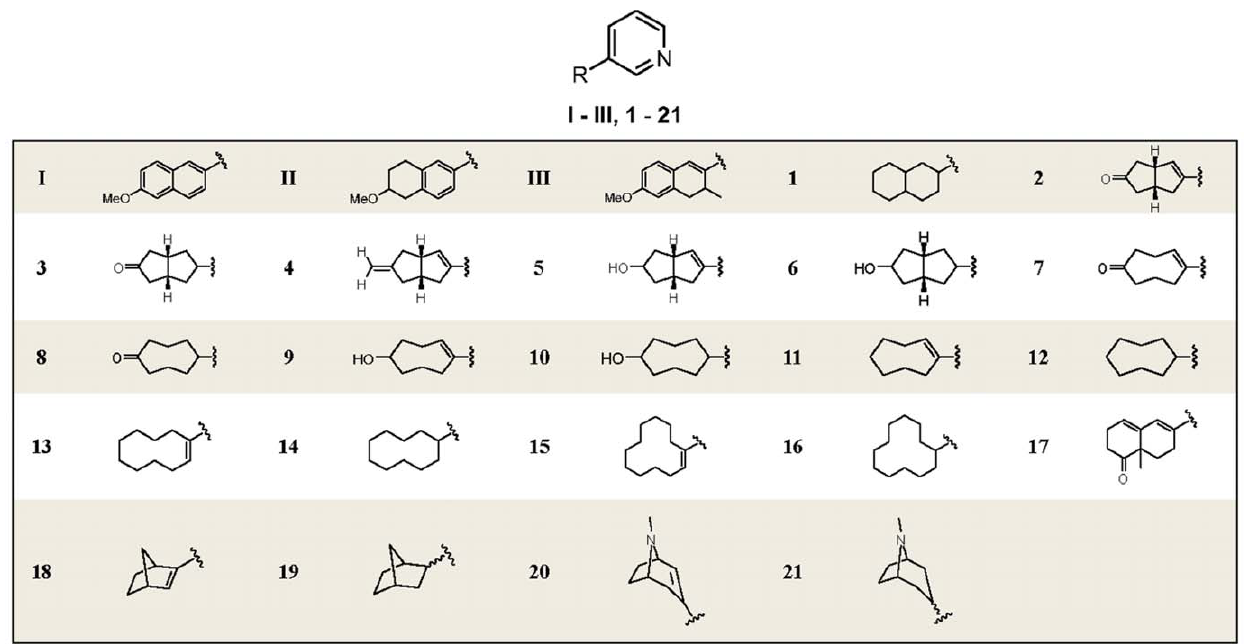
Figure 8. Structures of references I–III and compounds 1–21.